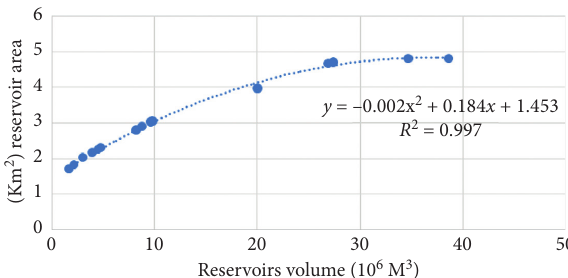
Figure 4: Surface-volume curve of the Golestan Dam